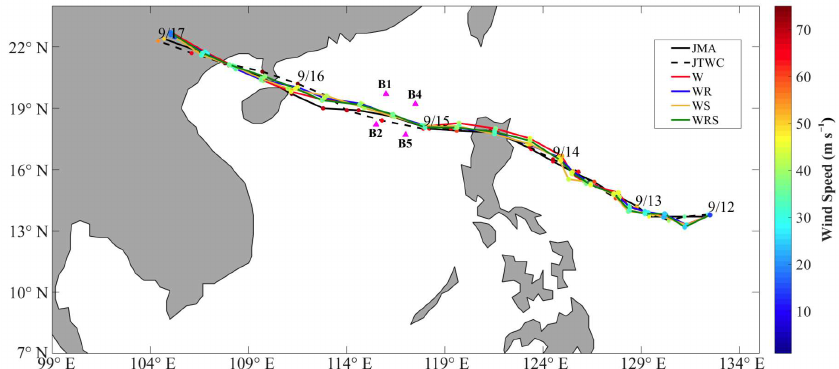
Figure 2. Best track of Typhoon Kalmaegi. JMA (bold black line), JTWC (dashed black line), W (red), WR (blue), WS (orange) and WRS (green). The dots represent the TC center location, and the colors represent V max (m s −1 ) between 00:00 12 September and 00:00 17 September, with a 6-h interval. The magenta triangles are the buoy locations.